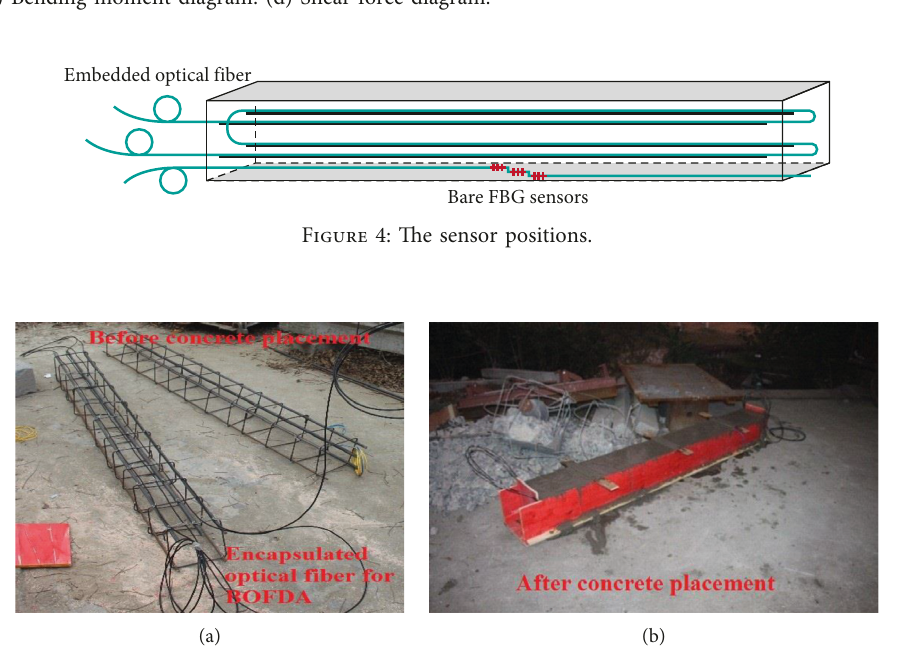
Figure 5: Layout of fiber optic sensors. (a) Installation of fiber optic sensors on the beam. (b) Poured concrete